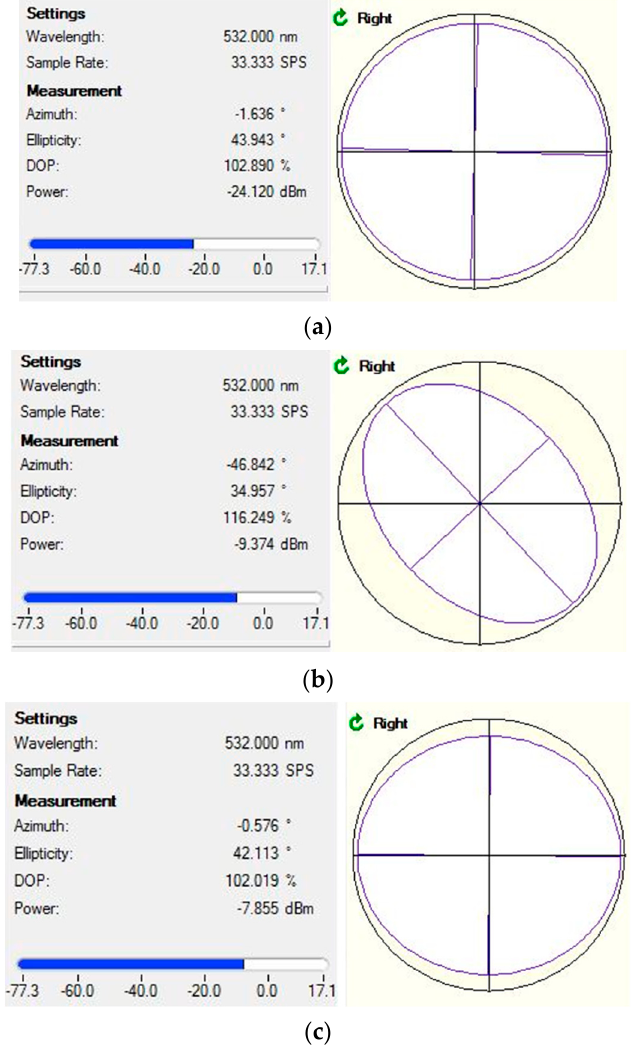
Figure 8. ( a ) Circularly polarized light obtained by vertically incident LCVR. ( b ) Elliptically polarized light obtained by oblique incidence. ( c ) Optimizing the control voltage to obtain circularly polarized light.